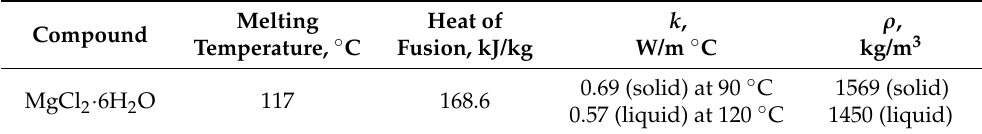
Table 1. Thermophysical properties of the PCM [29].